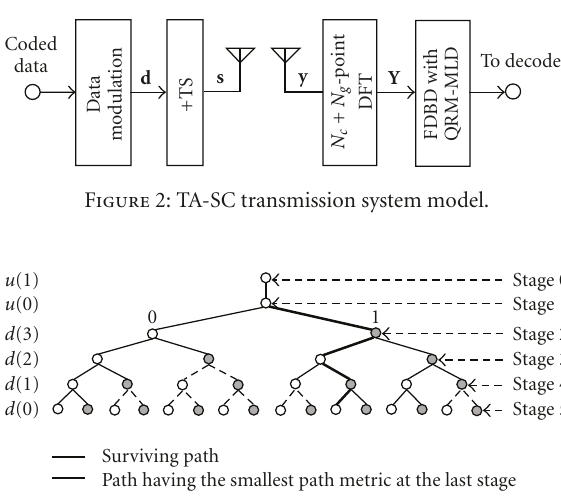
Figure 3: An example of QRM-MLD ( M = 3) with BPSK when N c = 4 and N g =